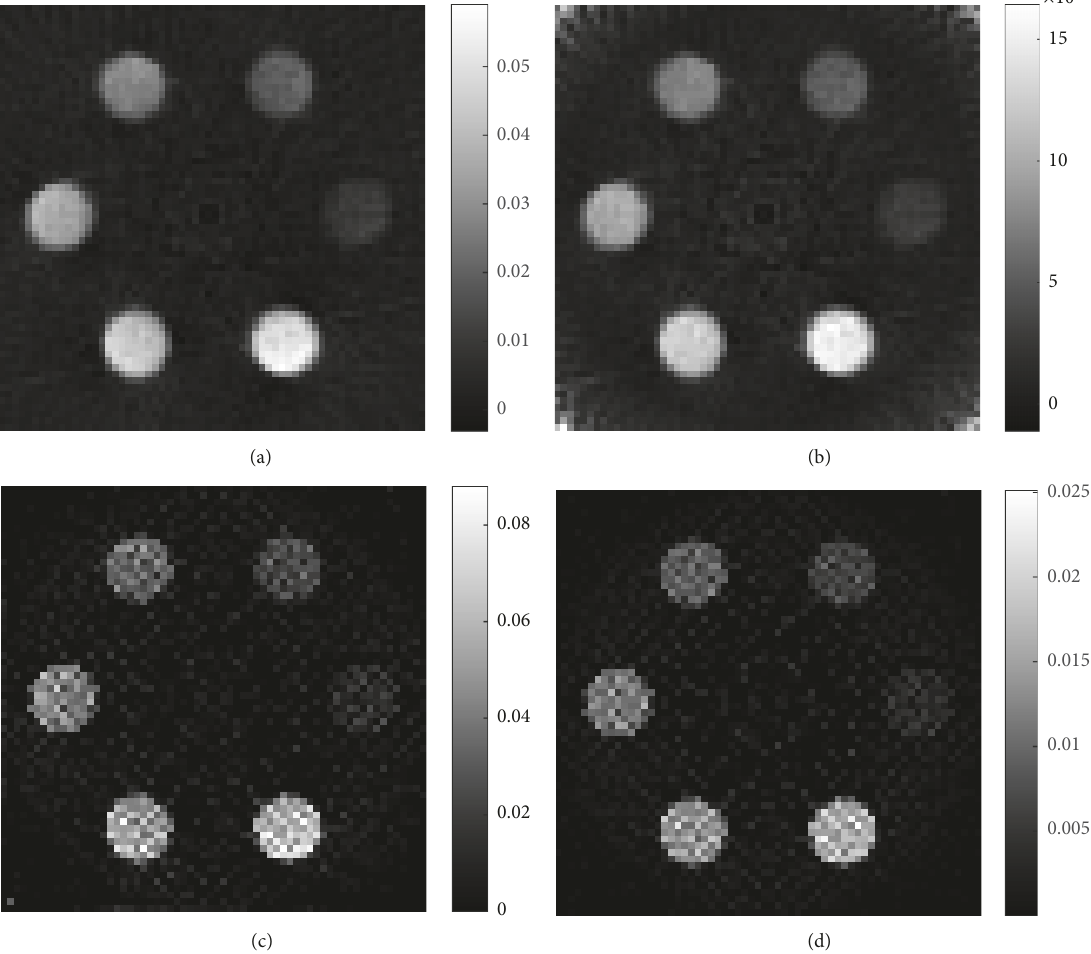
Figure8:ReconstructedXFCTimagesofphantom 𝐴 .(a)ReconstructedbyFBPwithoutcorrection,(b)reconstructedbyFBPwithcorrection, (c) reconstructed by MLEM without correction, and (d) reconstructed by MLEM with